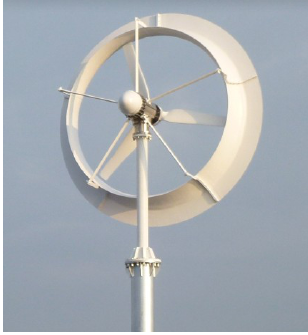
Figure 1. Wind-Lens turbine (rated power of 3 kW at 11 m/s wind speed).